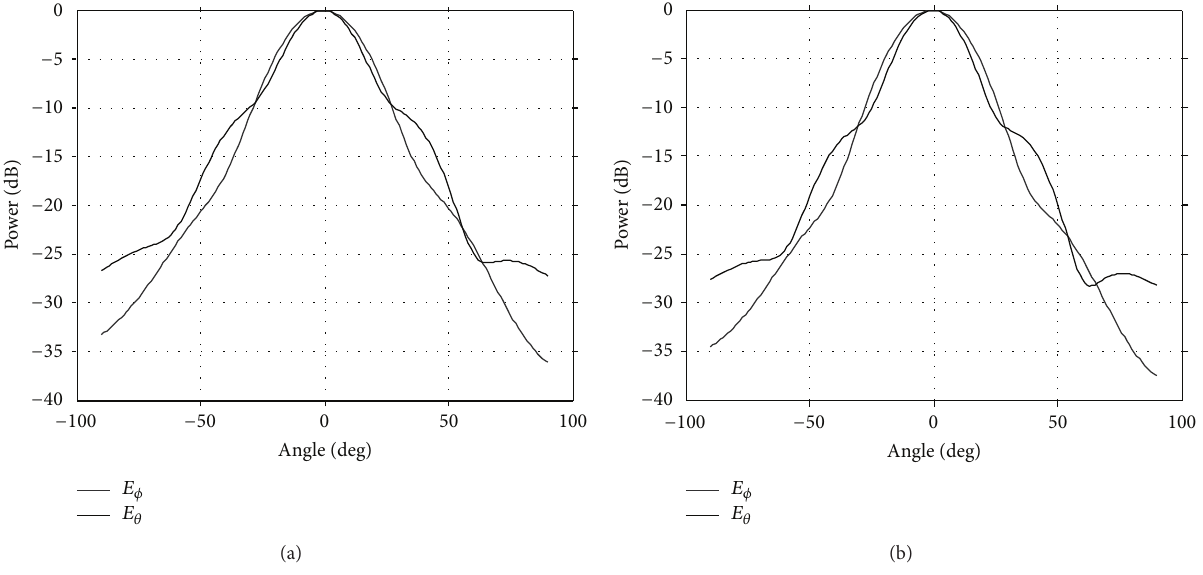
Figure 19: Comparison of amplitude radiation pattern of conical horn: (a) 𝑟 = 𝐷 2 /𝜆 , (b) 𝑟 = 2𝐷 2 /𝜆 .